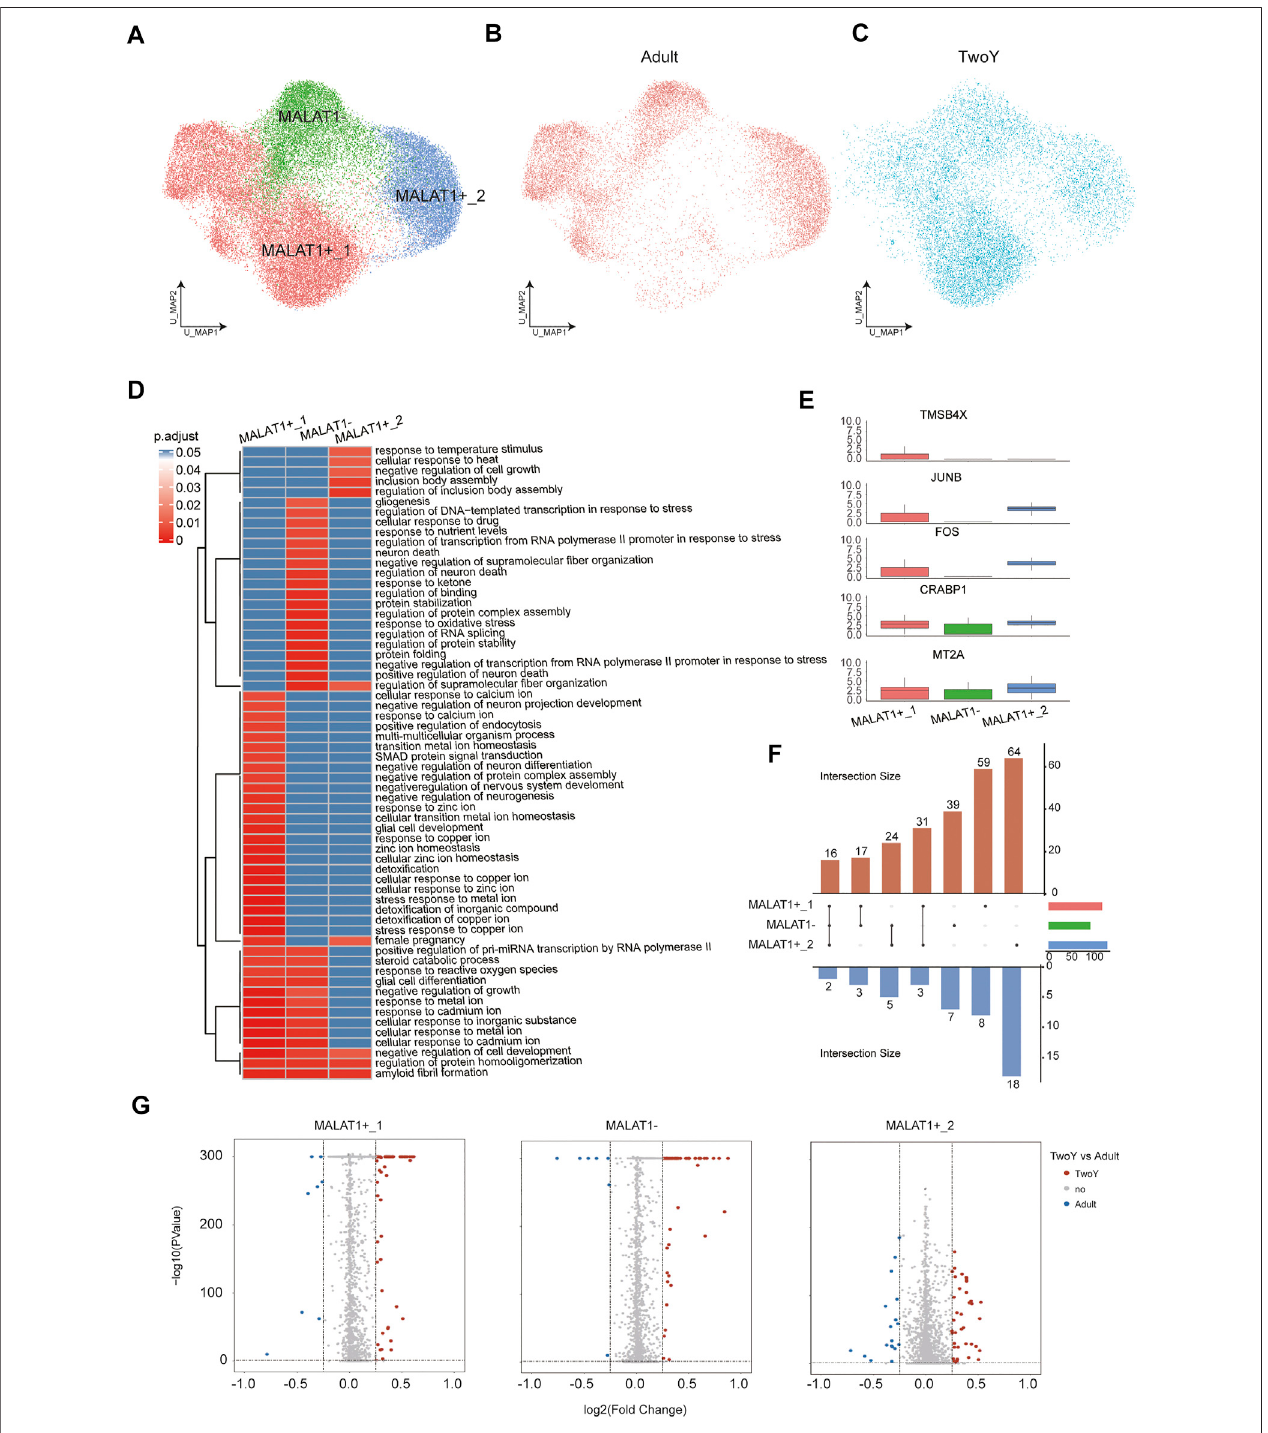
FIGURE6| ComparisonwithreferencedatafromadultrodPRs. (A) AUMAPmapofreferenceadultdataandTwoYdataamongrodPRscoloredbyclusters. (B) A UMAPmapofreferenceadultdatawithinrodPRs. (C) AUMAPmapofTwoYdatawithinrodPRs. (D) HeatmapshowstheenrichmentlevelofGOtermsineachcelltype. (E) Boxplots show the expression patterns of differentially expressed genes in each cell subtype. (F) An Upset plot enables visualization of the number of up-regulated and down-regulated genes ineach cell subtype (TwoY vs. adult). Thecell subtypes connected bythe straight linein the middle refer tothe subpopulations with the same differentially expressed genes. The corresponding blue bars below refer to the number of co-owned down-regulated genes, and red bars above refer to the number of co-owned up-regulated genes. The columns on the right represent the total number of differential genes between TwoY and adult in each subtype. (G) Volcanoplotshowingthedifferentiallyexpressedgenesineachcelltypesbetweentheretinasofadultsandyoungchildren.Genesareplottedaslog2foldchangeversus the − log10oftheadjusted p -value.Genesinreddenoteupregulationintheretinaofyoungchildren,whilebluedenotesupregulationinadultretina.Insigni fi cantgenesare colored in grey. Thresholds are shown as dashed lines.